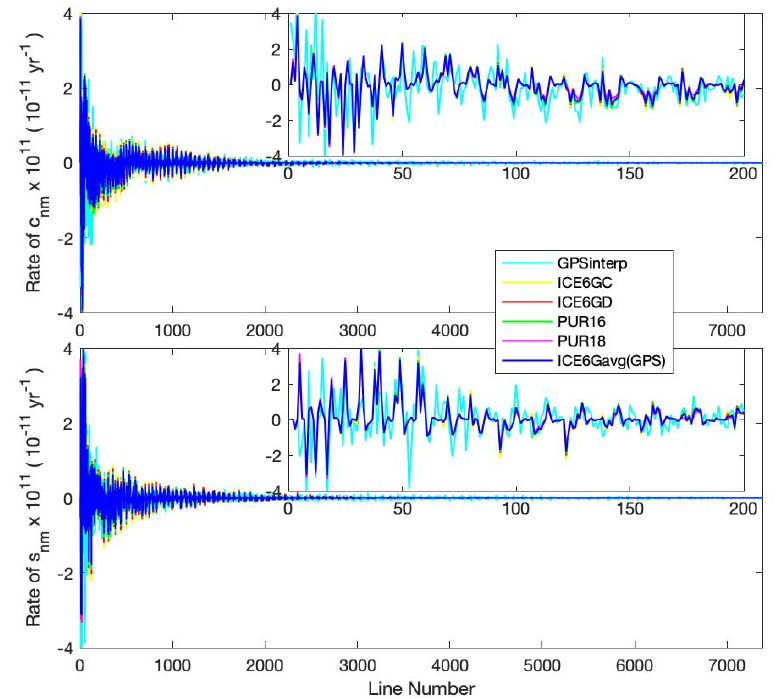
. . c X nm and s X nm for the uplift rates as derived from ICE6GC / D, PUR16 / 18, GPSinterp, Figure 9. Coe ffi cients Figure 9. Coefficients X c  and X s  for the uplift rates as derived from ICE6GC/D, PUR16/18, GPSinterp, nm nm and ICE6Gavg (GPS). The coe ffi cients for line number ≤ 200 are displayed in small boxes to show and ICE6Gavg (GPS). The coefficients for line number ≤ 200 are displayed in small boxes to show more more details.